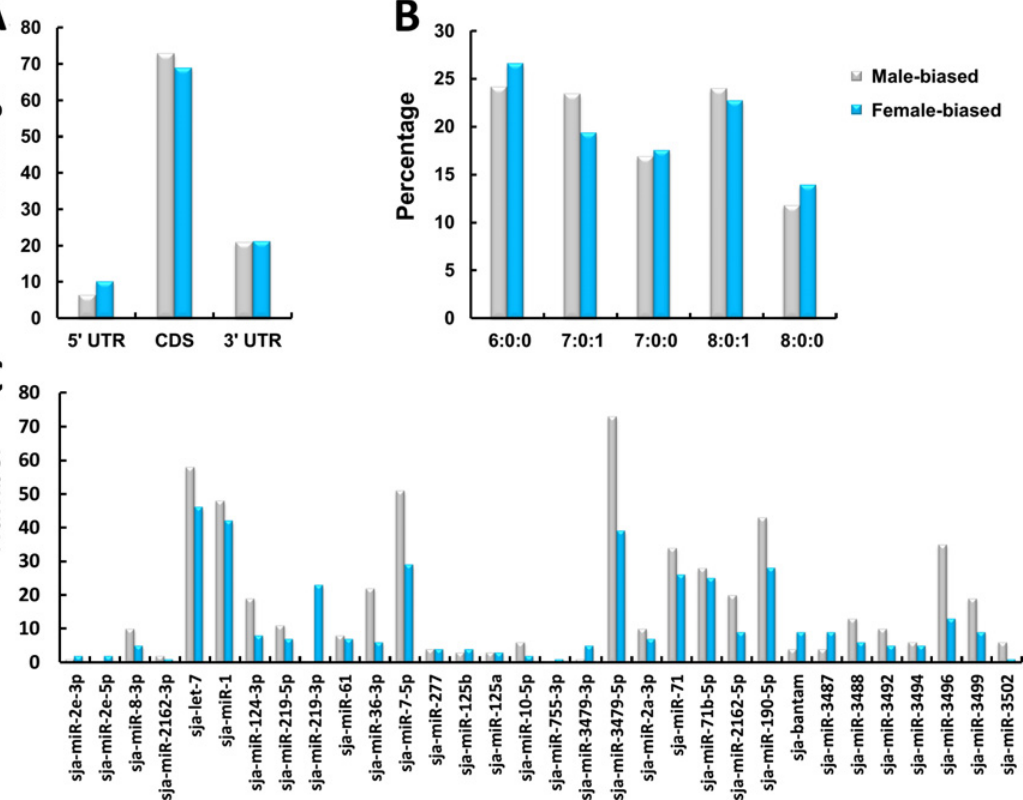
Fig 5. Analysis of putative miRNA target sites within gender-biased expressed genes. A. Distribution of miRNA target sites within different mRNA regions (5'-UTR, CDS and 3'-UTR); B. Distribution of miRNA target sites with different seed types. The "X:Y:Z" notation used for describing the seed represents the size of the seed (X), the number of mismatches (Y) and the number of G:U wobble pairs (Z); C. Target site number for individual